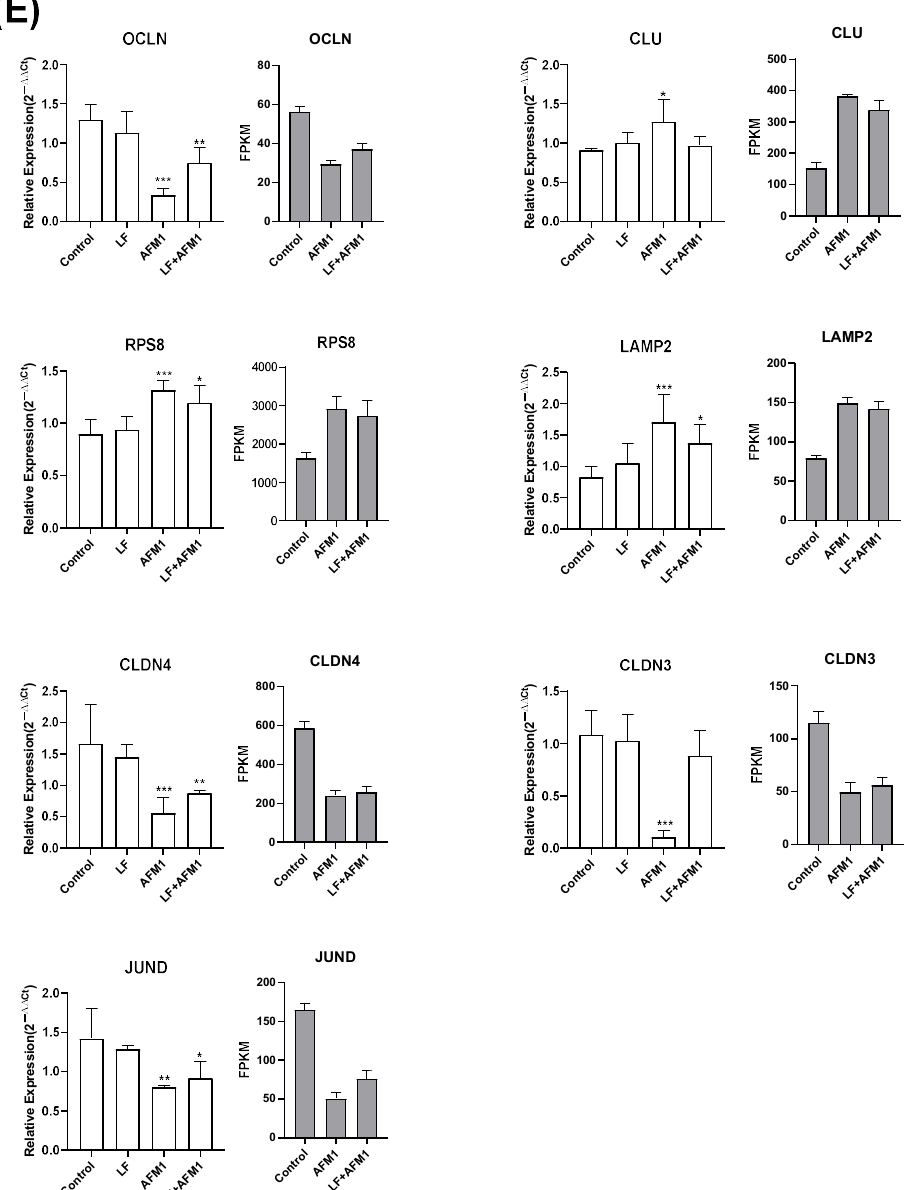
Figure 5. Transcriptome analysis of differentiated Caco-2 cells exposed to LF and AFM1. ( A ) The number of differentially expressed genes (DEGs). ( B ) Unsupervised PCA analysis. ( C ) Venn diagram depicting the DEGs regulated by LF and AFM1 treatment. ( D ) The intestinal integrity related KEGG pathways enriched by DEGs. ( E ) The gene expression level measured by qRT-PCR and RNA-seq. These selected genes were not DEGs between Control and individual LF treatment. LF represents individual 100 µ g/mL LF, AFM1 represents individual 8 µ g/mL AFM1, LM represents the combination of 100 µ g/mL LF and 8 µ g/mL AFM1. * represents p < 0.05, ** represents p < 0.01, *** represents p < 0.001.